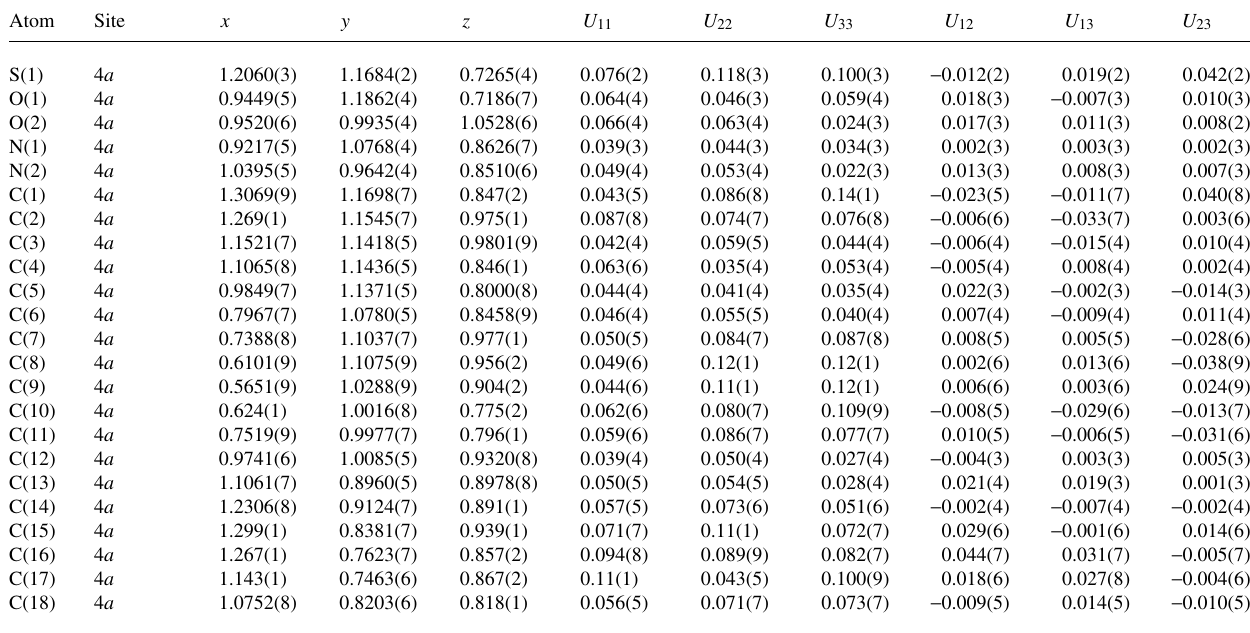
Table 3. Atomic coordinates and displacement parameters (in Å 2 ) .